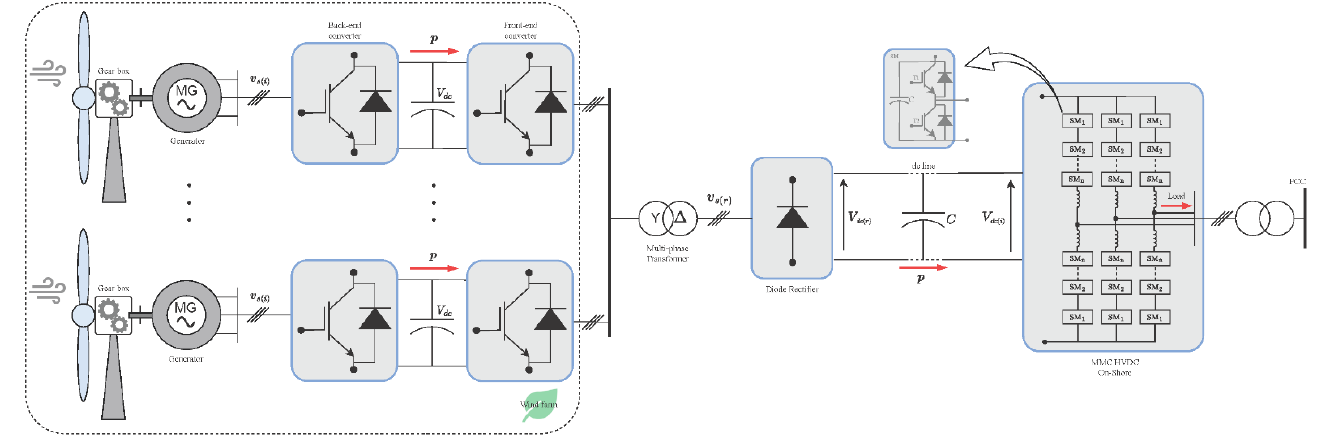
Figure 1. System topology, offshore AC link in detail.